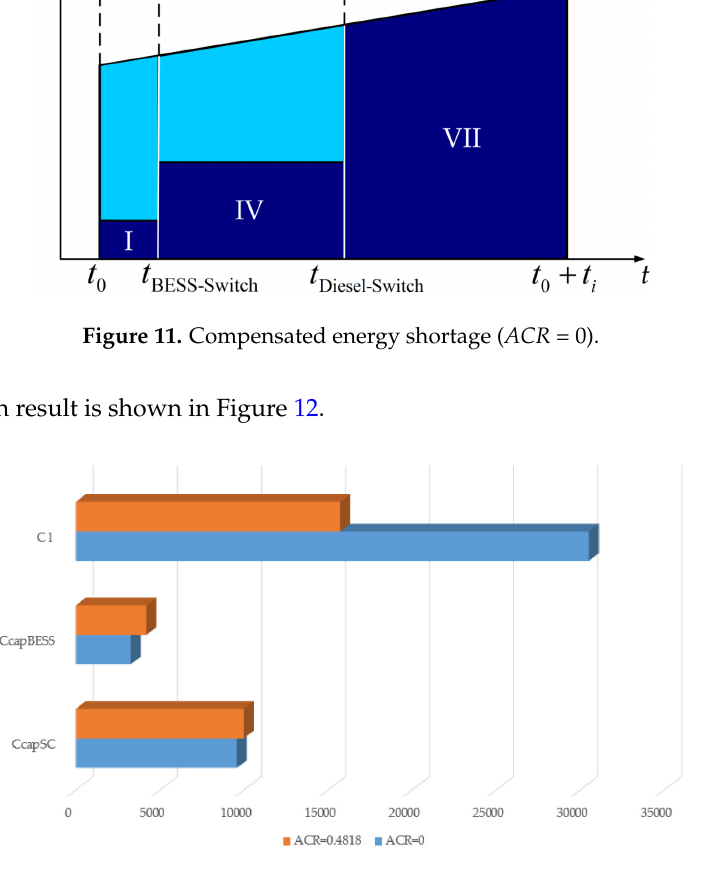
Figure 12. Calculation result at ACR = 0.